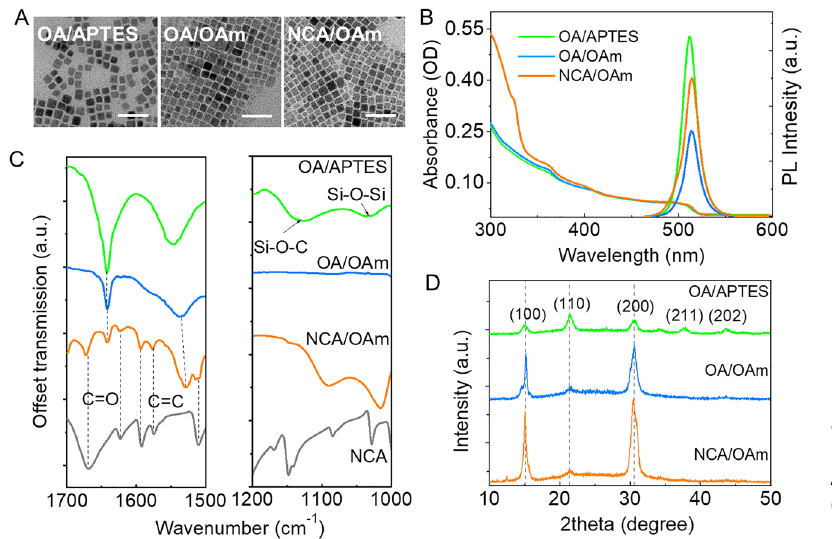
Figure 1: (A) TEM images, (B) UV – Vis absorption and PL emission spectra, (C) FTIR spectra and (D) XRD patterns of OA/ APTES-CsPbBr 3 (green), OA/OAm-CsPbBr 3 (blue) and NCA/OAm-CsPbBr 3 (orange) PeNCs. Scale bars are 50